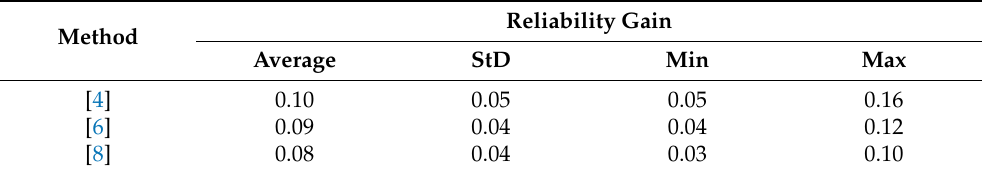
Table 10. TFEP reliability gain with respect to other fuzzy thematic classification